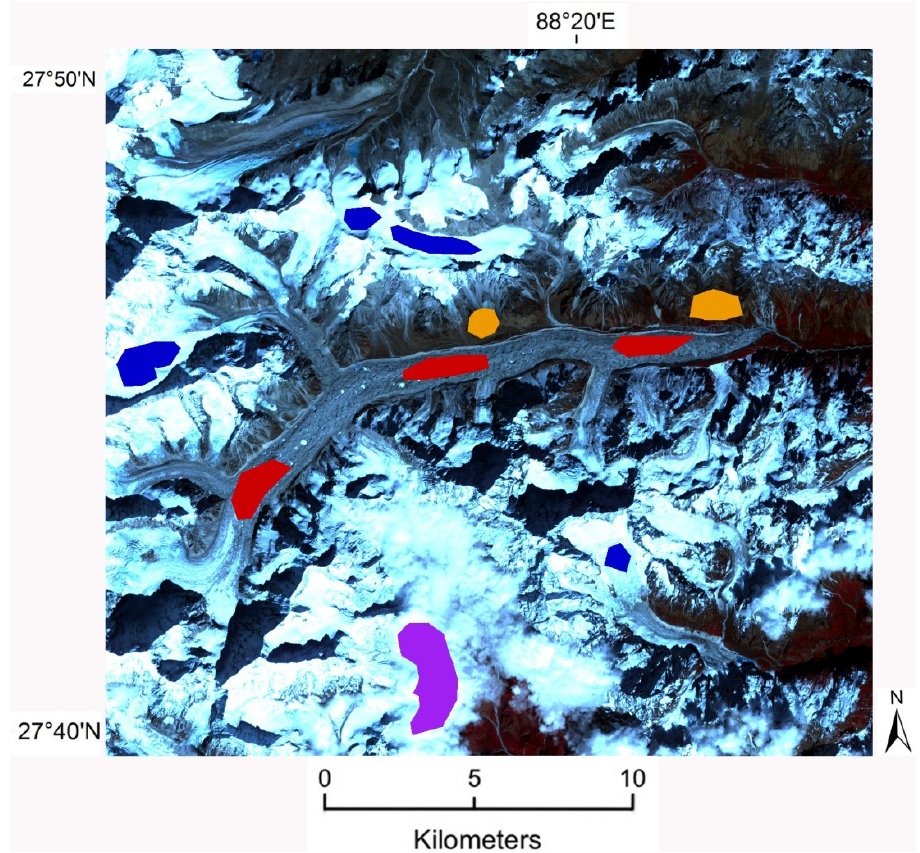
Figure 4. ASTER color composite 321 showing ROIs digitized manually and shown as solid polygons: Debris (red), snow/ice (blue), bare rock and sand (yellow) and clouds (magenta) were digitized and all four classes were used for the GCLM texture measures; only the first three classes were used for the geostatistical analysis (Section